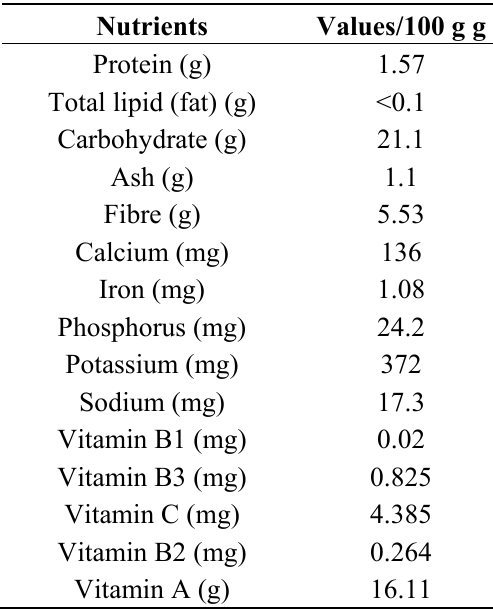
Table 2. Nutritional values of fruit